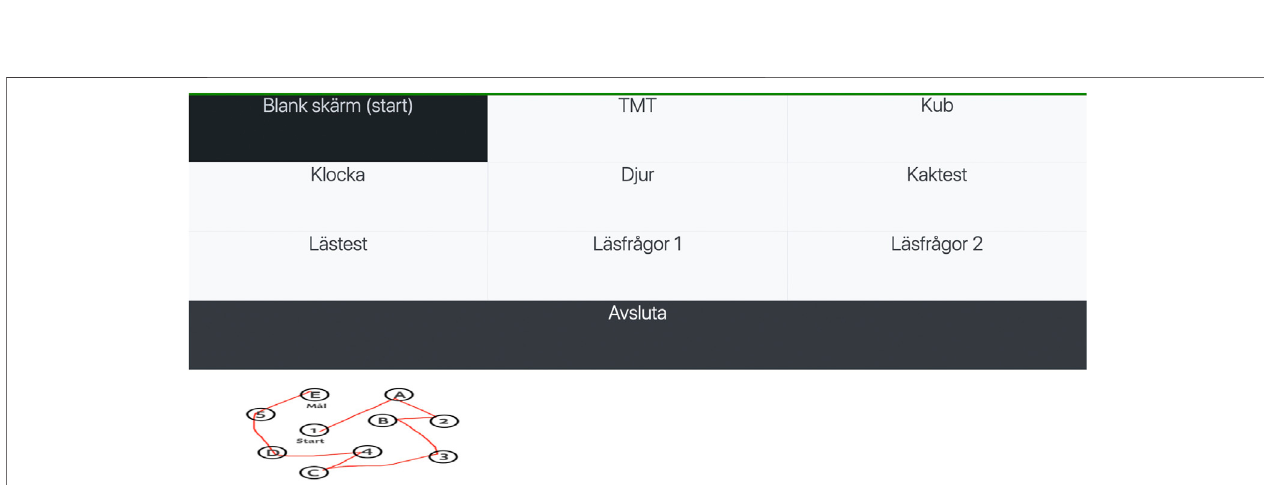
FIGURE 2 | Diagram showing each sensor component and how they are linked together with the data capturing framework.